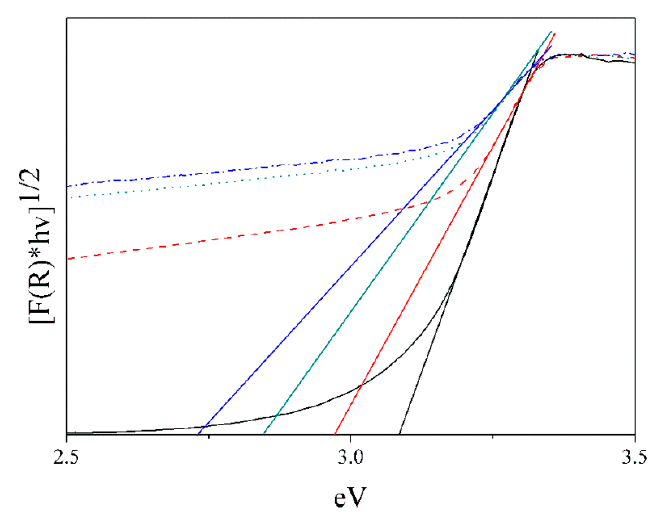
6 of 14 Figure 5. Raman spectra of ( a ) anatase TiO 2 (black dotted line), the wurtzite ZnO flowers (red dashed line), and the ZnO- TiO 2 core-shell flowers (blue solid line) and ( b ) ZT-rGO with 0.5 (red dotted line), 2 (green dashed line), and 5 wt % (blue